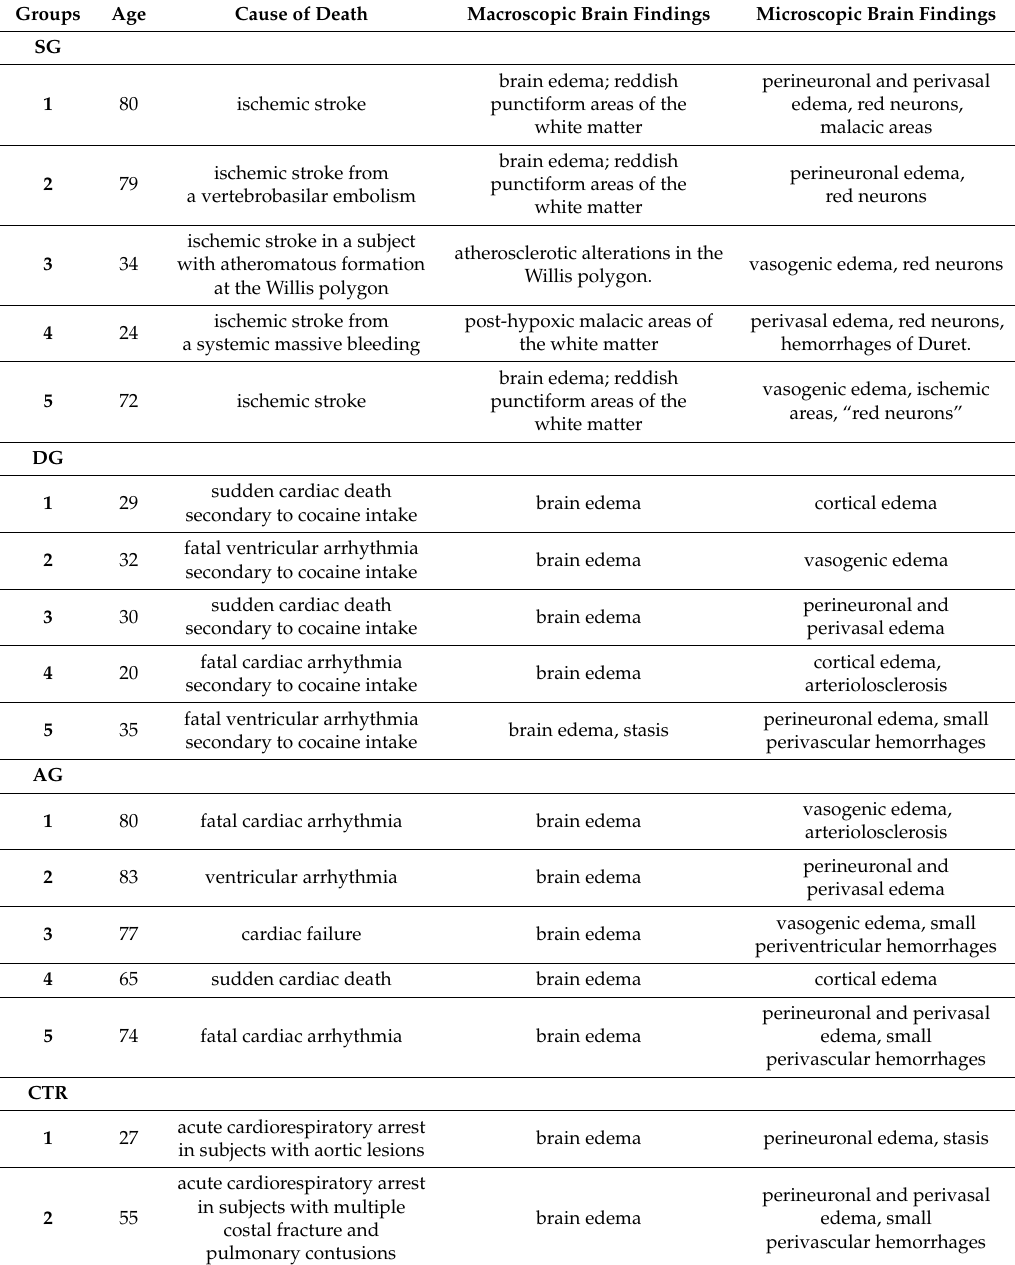
Table 2. Selected groups: SG, stroke group; DG, drug group; AG, aged group; CTR, control